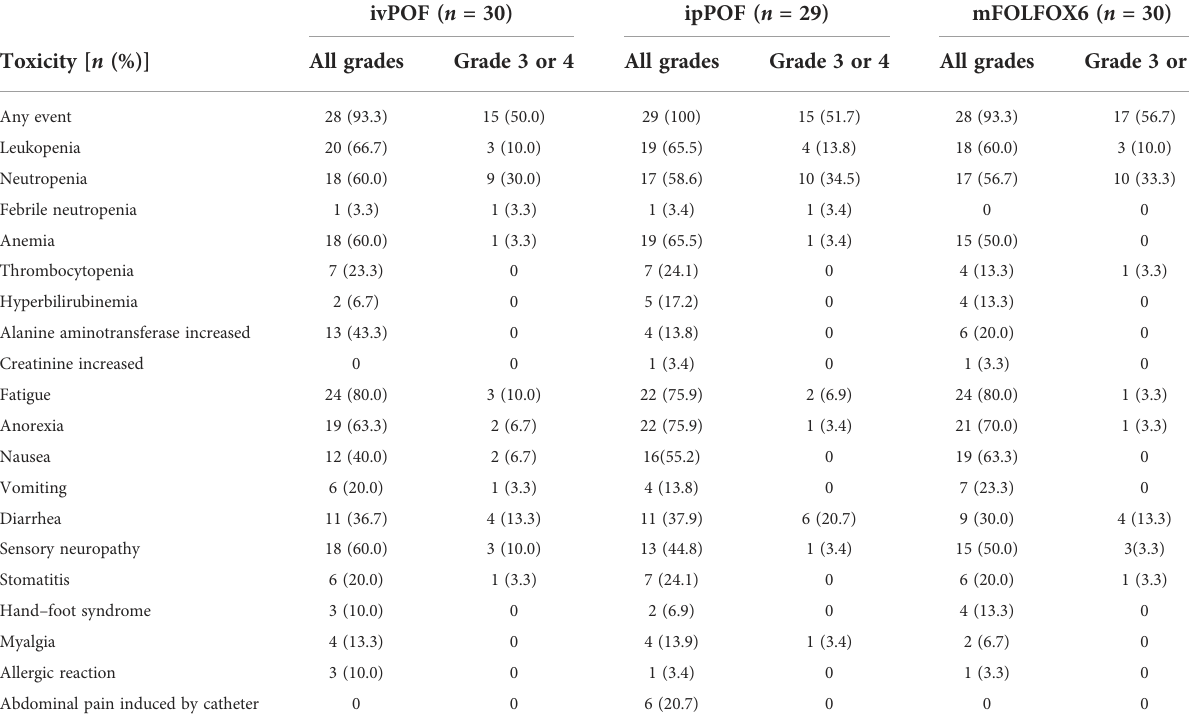
TABLE 4 Adverse